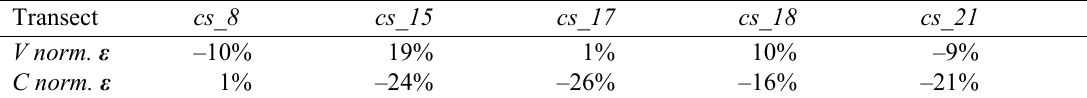
Table 2 Velocity and suspended sediment concentration calibration at selected transects from DuMars (2002) measurements. Transect cs_8 cs_15 cs_17 cs_18 cs_21 V norm. ε